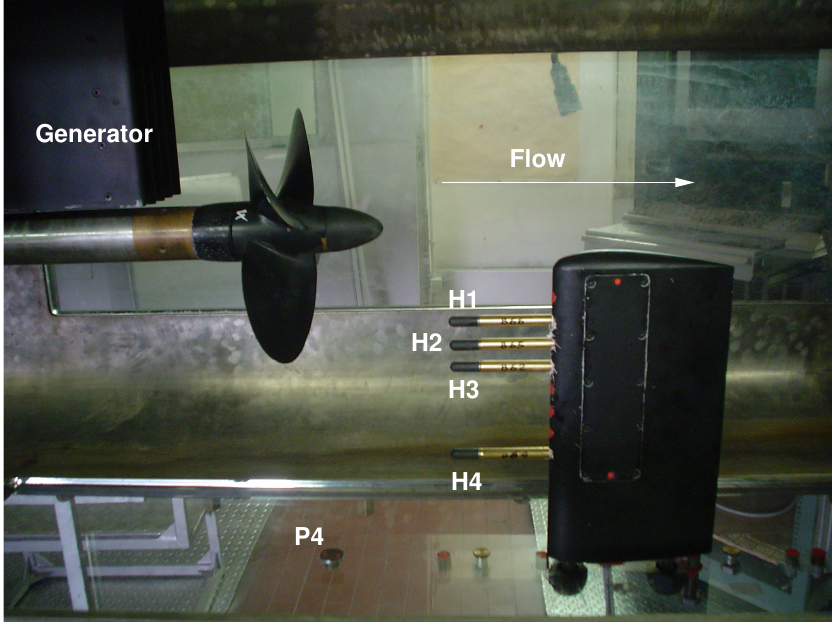
Figure 5. Hydrophone strut for inflow pressure